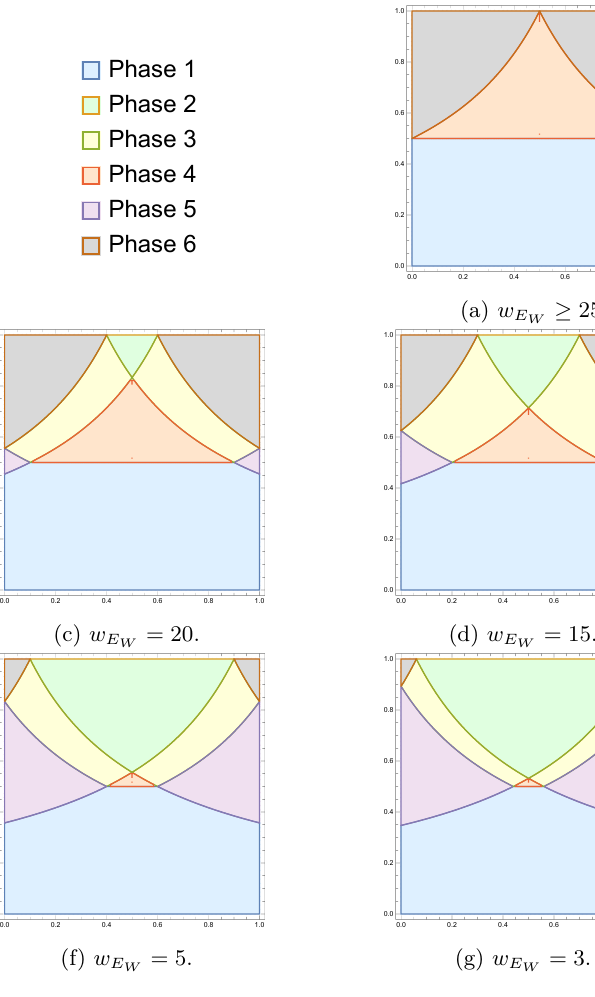
= w , keep w + w = 50 fixed, and vary w . The horizontal axis is w A C 1 C 2 A B E W where w = w + w C C 1 C 2 w A + w B + w C